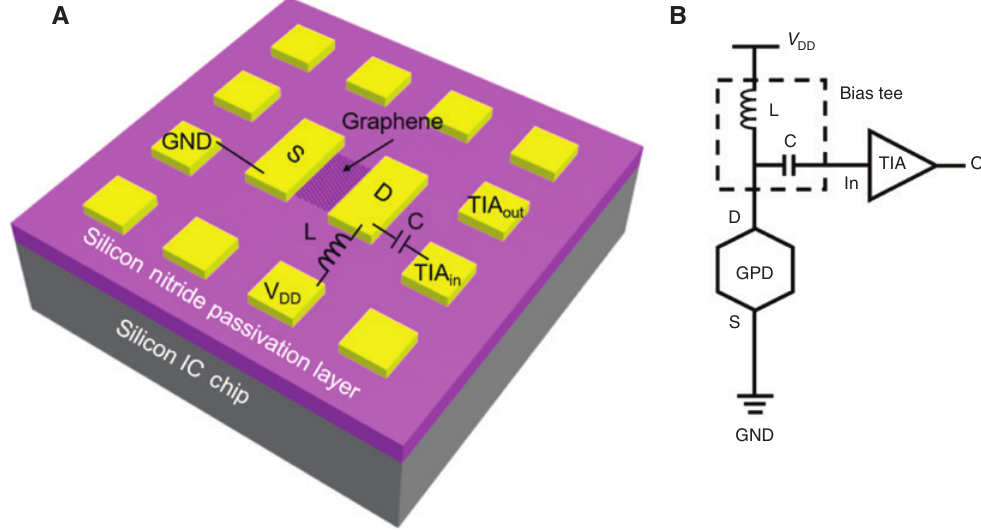
Figure 1: Three-dimensional schematic of GPD-based broadband prototype optical receivers (A) and schematic illustration of the corre- sponding circuit implementation (B) are